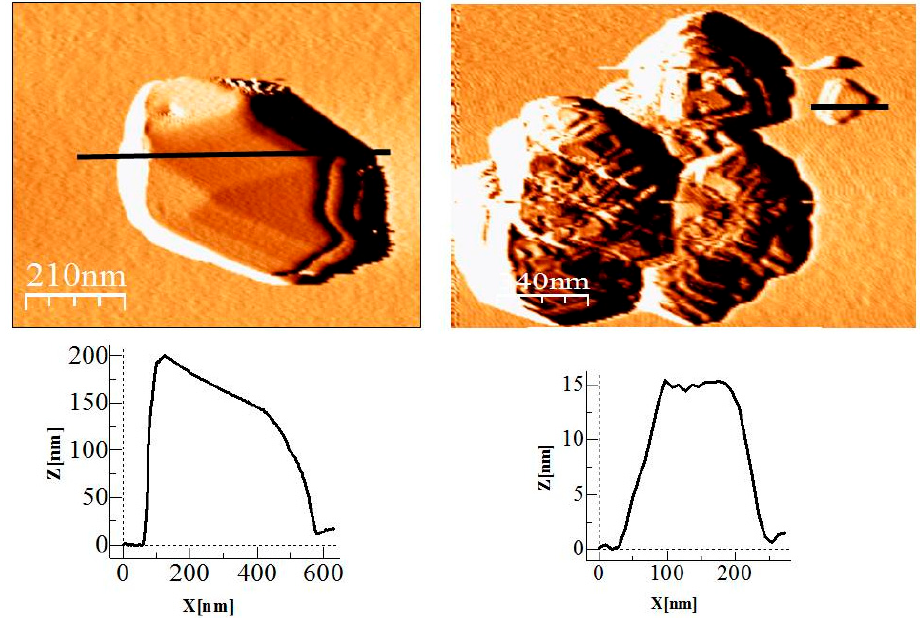
Figure 5. AFM images of {[Cu 2 ( μ 3 -adeninato) 2 ( μ -Hadip) 2 ]} n ( 1n ) obtained in experiment c : Octahedral sub-micrometer and nanometer particles sizes ( top ); and the corresponding height profiles along the lines ( bottom ).